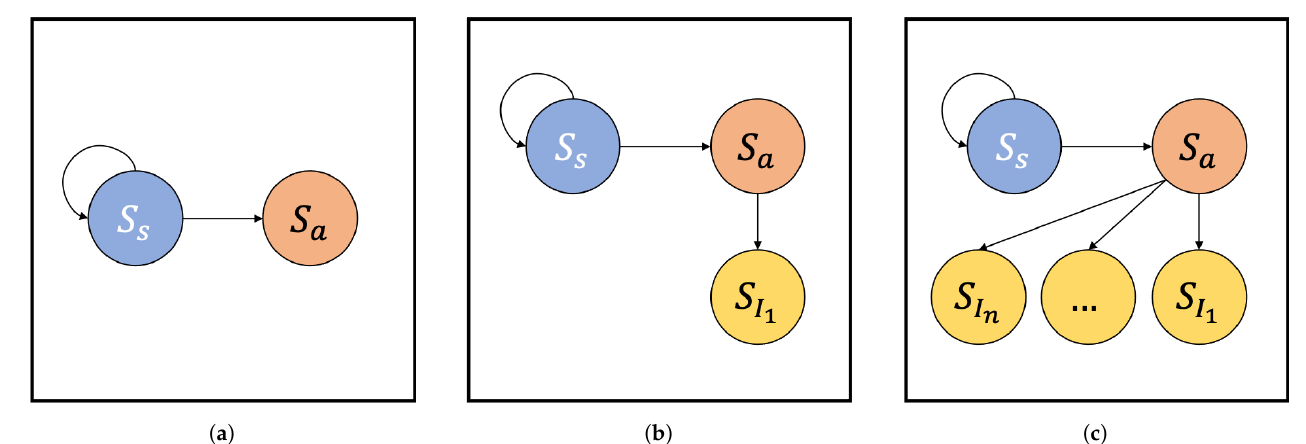
Figure 2. Model definition. In Figure 2a, we show the case in which our model can only detect the base state S s and the anomaly state S a . In Figure 2b, we show the case in which the first anomaly has been described by the user, which then defines the class S I . Clearly the model may still recognize the base case S s and a novel anomaly S a . Finally, whenever the 1 user describes a novel anomaly S I , this is added to the model while keeping also the base cases S s and S a in addition to the 2 other defined